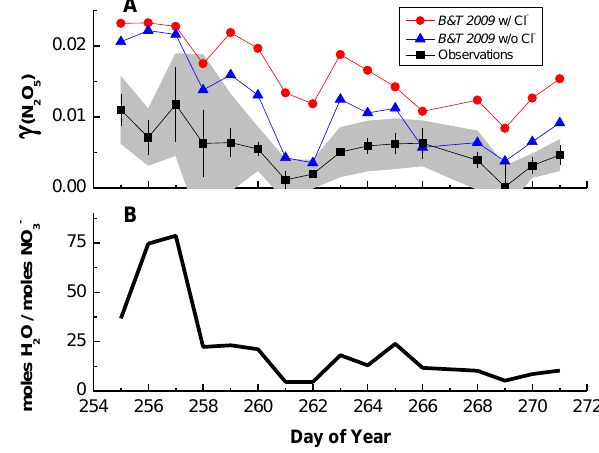
Fig. 3. (A) A full time series of measured particle surface area con- centrations (0.01–0.6µm) at ambient RH conditions for the study period. (B) A full time series of AMS reported non-refractory particle composition for the study period with organics (shown in greens) differentiated by factor analysis as oxidized organic aerosol (OOA), biomass burning organic aerosol (BBOA), and marine or- ganic aerosol (MOA). In general, high particle surface area corre- lated well with aerosol mass loadings indicating only a few periods in which submicron particle surface area were influenced by fresh sea salt emissions.